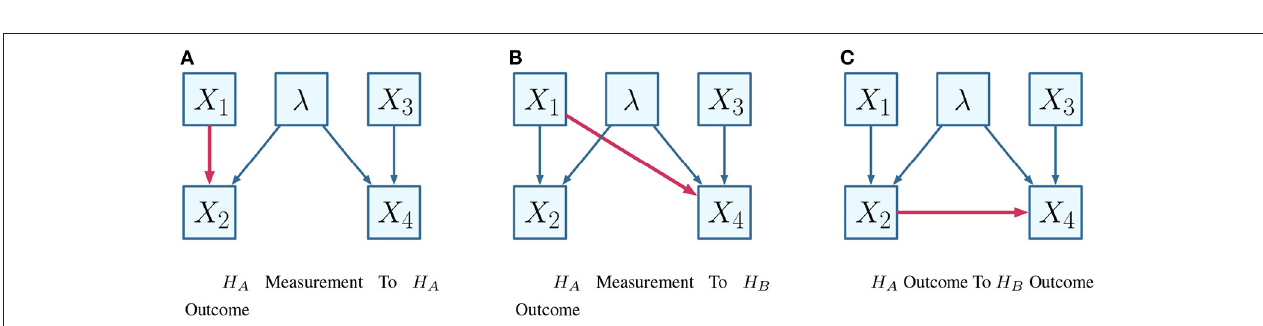
FIGURE 4 | Alternative mapping of causal model to contextuality scenarios with functional assignments. (A) Causal diagram. (B) Mapping from causal model to contextuality scenarios.